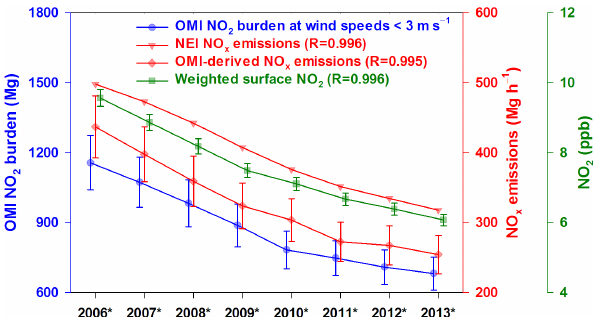
Figure 9. The 3-year moving trends of the total NEI NO x emis- sions, the total OMI-derived NO x emissions, the total OMI- observed NO 2 burdens under the weak-wind-speed condition, and the area-weighted average AQS surface NO 2 measurements for all selected urban areas during 2006*–2013*. Error bars express the ± 1 SD of the estimates. R values shown are the correlation coeffi- cients with the OMI-observed NO 2